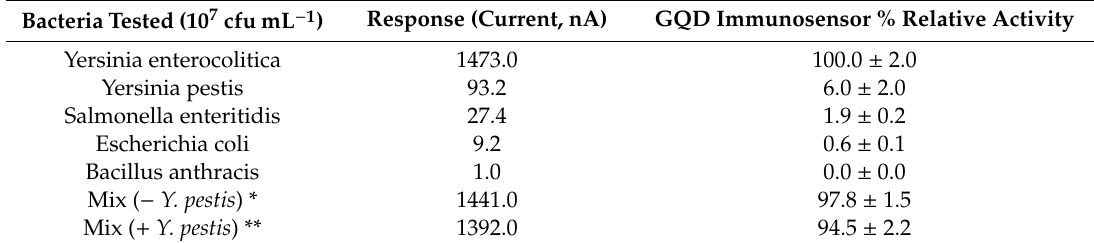
Table 2. Current response profile for Y. enterocolitica binding in milk compared with other pathogenic bacteria, and the percentage of cross reactivity of non-specific bacteria ( n = 3).